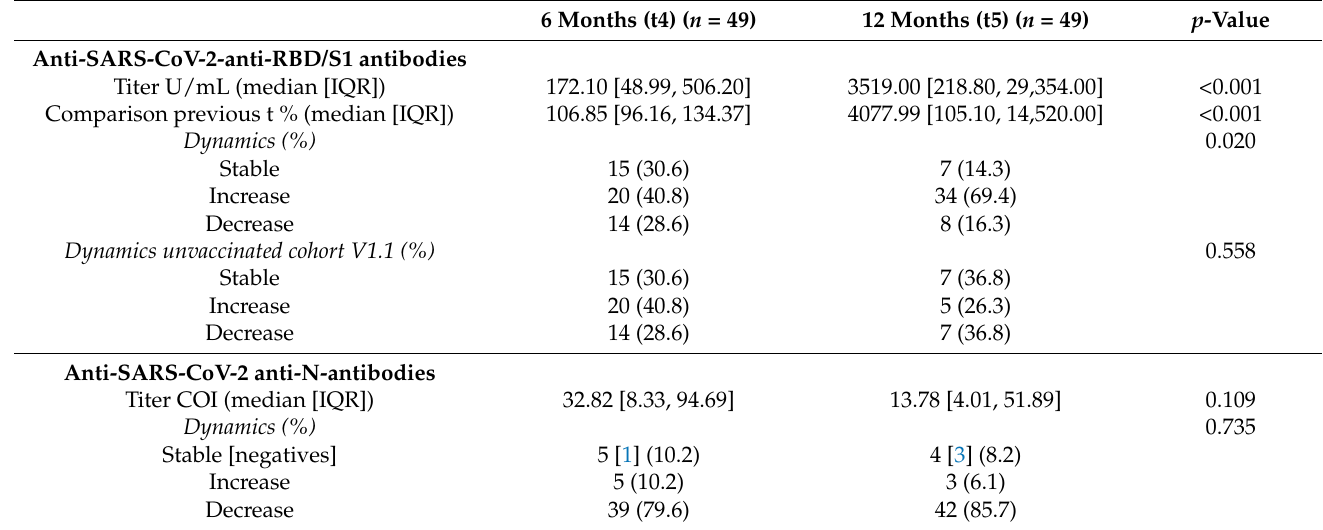
Table 4. Comparison of SARS-CoV-2 ab of COVID-19 recovered subjects after 6 and 12 months (all